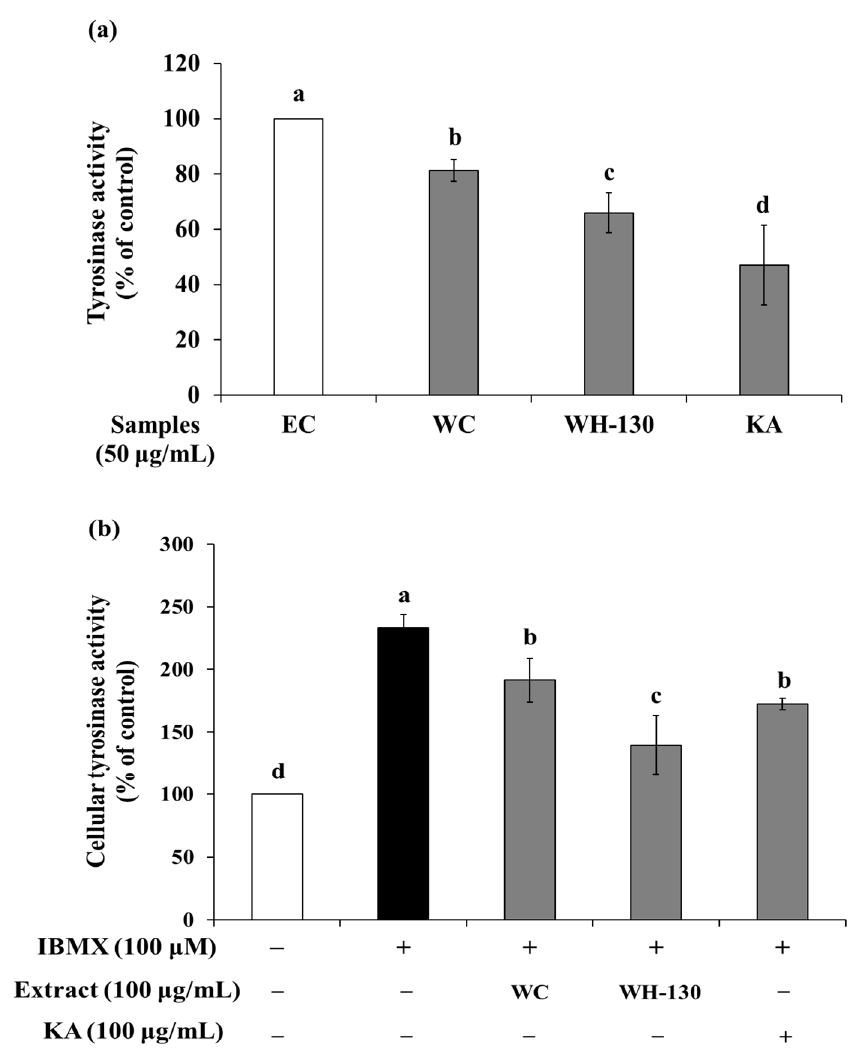
Figure 5. ( a ) Effects of licorice extracts (WC and WH-130) on mushroom tyrosinase activity. EC, enzyme control; KA, kojic acid. KA was used as a positive control. ( b ) Effects of licorice extracts (WC and WH-130) on cellular tyrosinase activity in B16F10 melanoma cells. Data are expressed as mean ± SD ( n = 3). Lowercase letters represent statistical differences at p < 0.05.